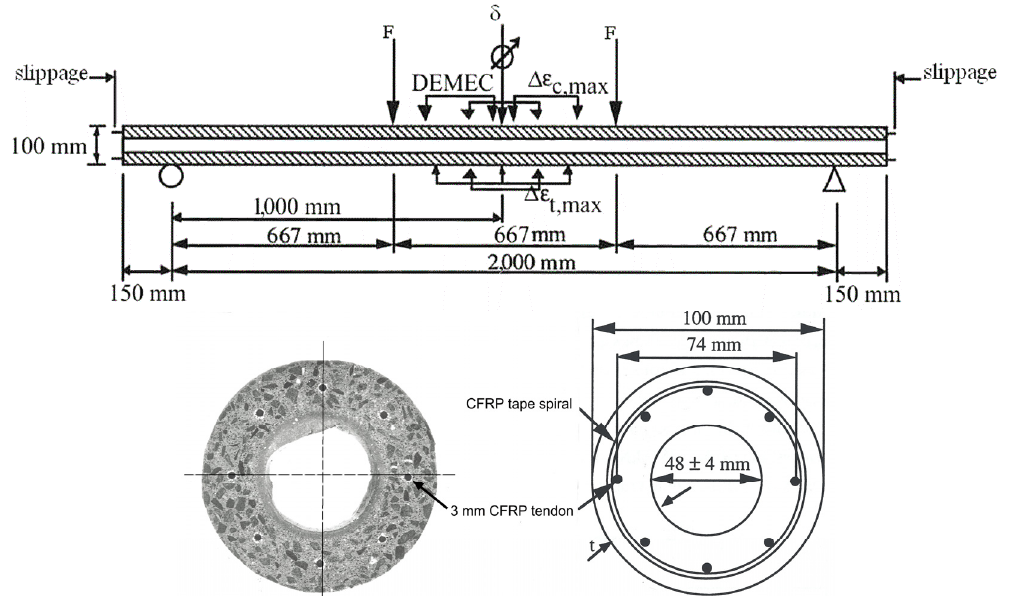
Figure 1. Cross-section of carbon fiber-reinforced polymer (CFRP) prestressed pole specimens and the bending load